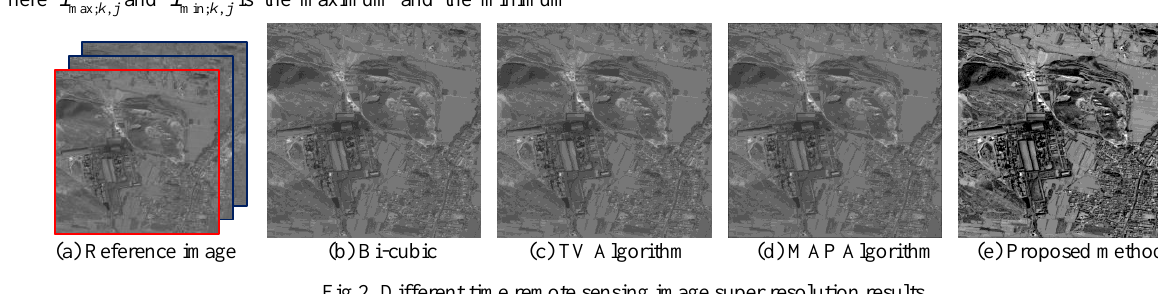
Fig.2. Different time remote sensing image super resolution